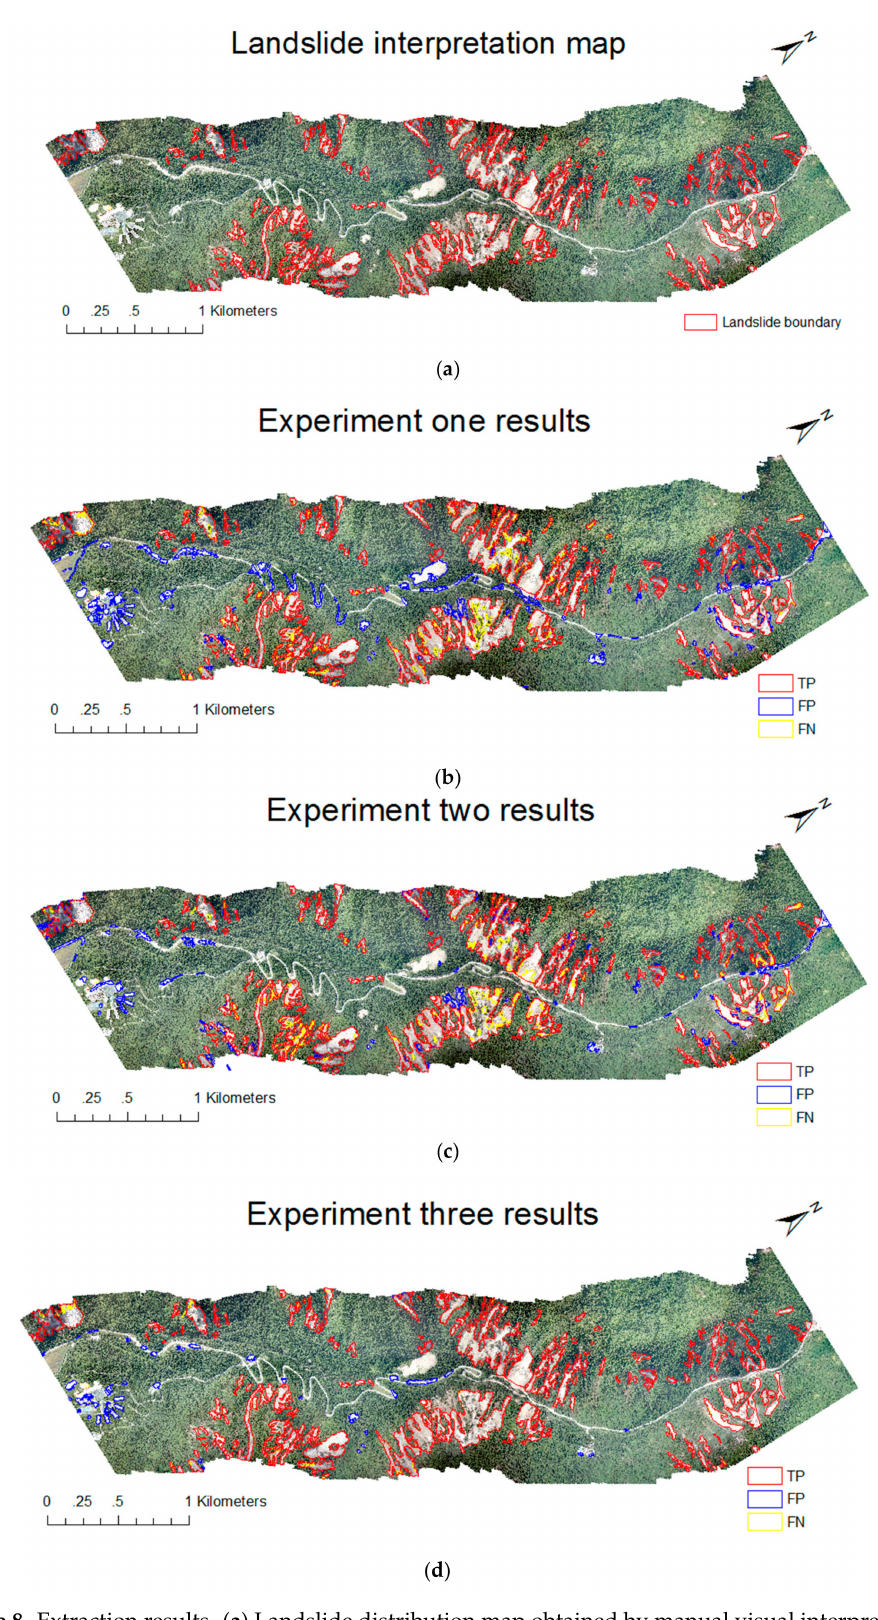
Figure 8. Extraction results. ( a ) Landslide distribution map obtained by manual visual interpretation; ( b ) Results of the U-Net + three-channel extraction; ( c ) Results of the U-Net + six-channel extraction; ( d ) Results of U-Net + six channels +